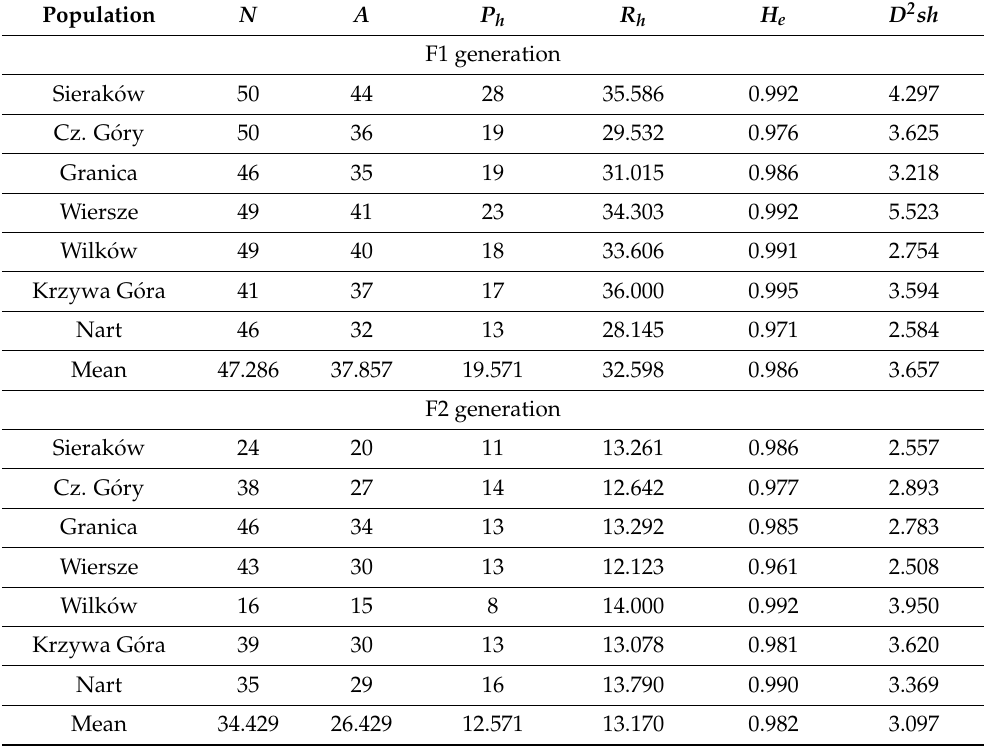
Figure 2. Haplotype frequencies expressed as a percentage ( Y -axis) for the analysed locations of maternal (F1) and progeny (F2) generations. Each colour on the graph corresponds to one of the 254 identified haplotypes. Table 2. Genetic diversity within a population of P. sylvestris L. based on 6 cpDNA markers. Number of haplotypes ( A ), the number of private haplotypes ( Ph ), haplotype richness ( Rh ), genetic diversity ( He ), and mean genetic distance between individuals ( D 2 sh